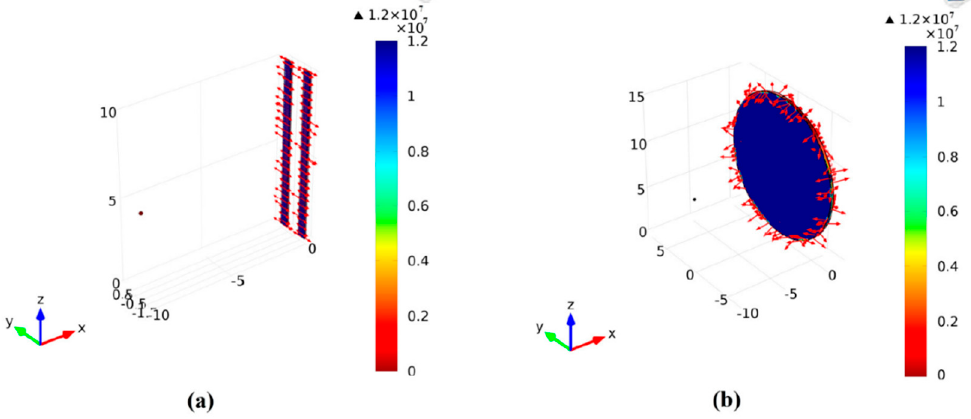
Figure 12. Electric field distribution for ( a ) two-bar collector, and ( b ) conventional collector